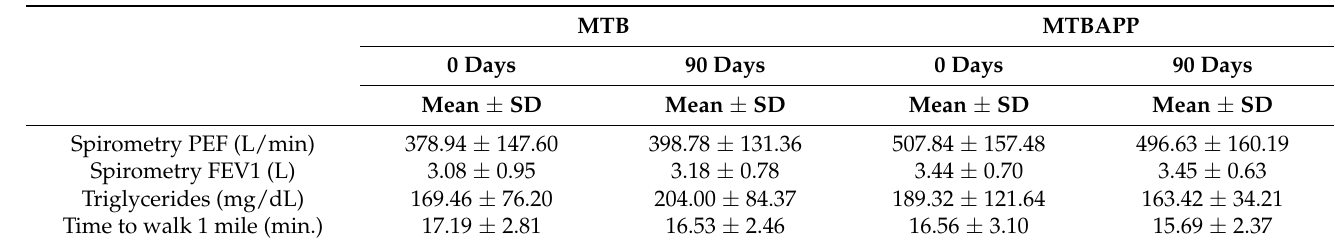
Table 3. Spirometry, triglycerides, and time to walk one mile data at the beginning and end of the